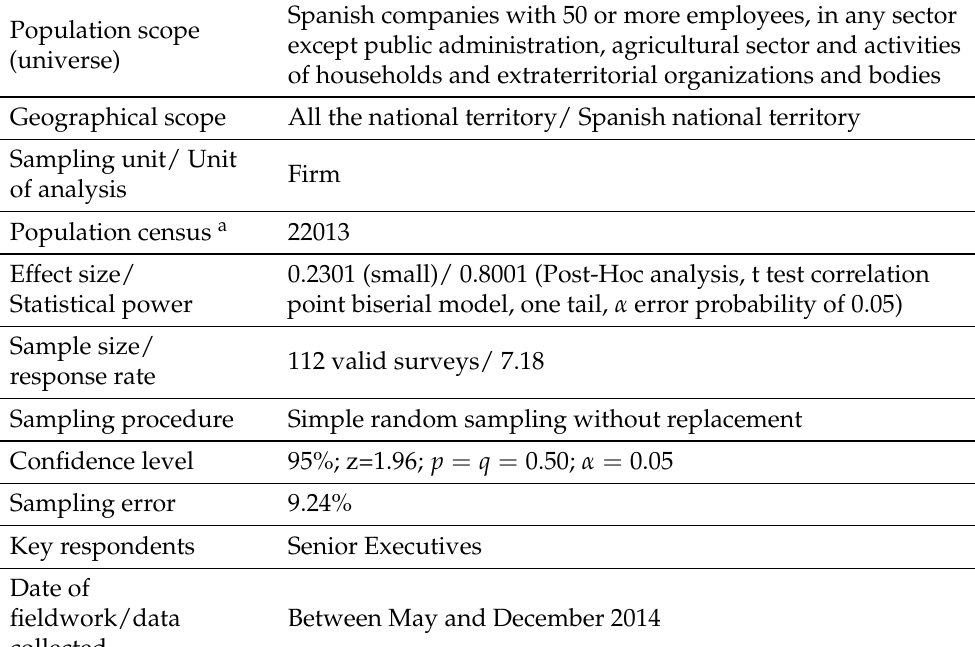
Table 9. Technical data sheet. (a) Source: DIRCE 2015 (Central Business Register, CBR or DIRCE in Spanish, on 1 January